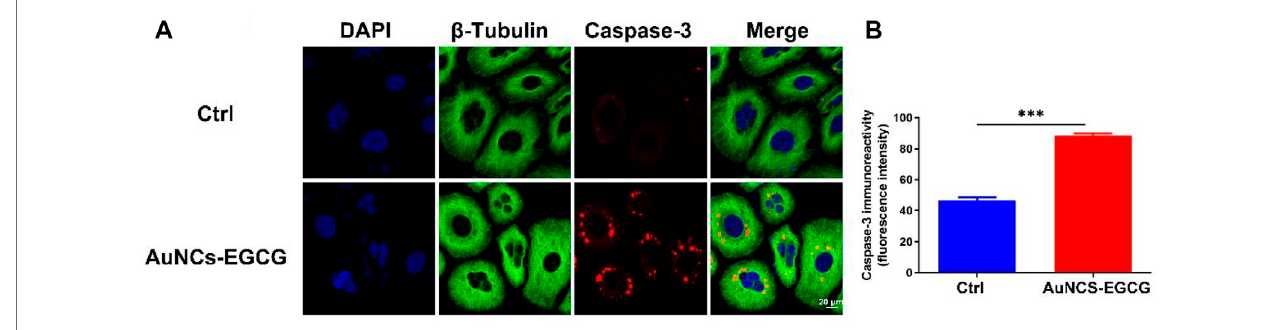
FIGURE 6 | NIR-responsive AuNCs-EGCG promoted the expression level of Caspase-3 protein in HepG2 cells (A,B) . Confocal microscopy immuno fl uorescence analysisofCaspase-3proteinexpressionanditssemi-quanti fi cationanalysis.Scalebarsare25 μ m.Themeanandstandarddeviation(SD)ofthedata( n =3)areshown. Statistical analysis: ppp p <